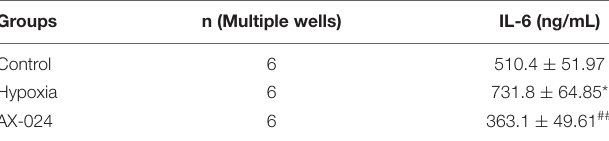
TABLE 2 | The level of IL-6 after AX-024 treatment in hypoxia-induced PASMCs proliferation. Groups n (Multiple